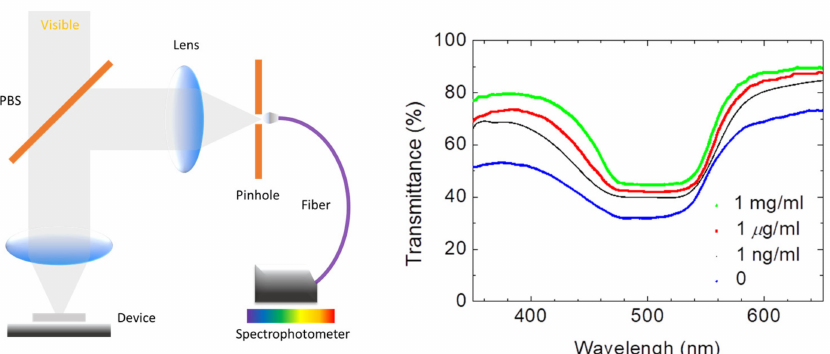
Figure 4. The schematic diagram of MRFS system and the spectra of the CLC test kit under 0–1 mg/mL of cTnI.